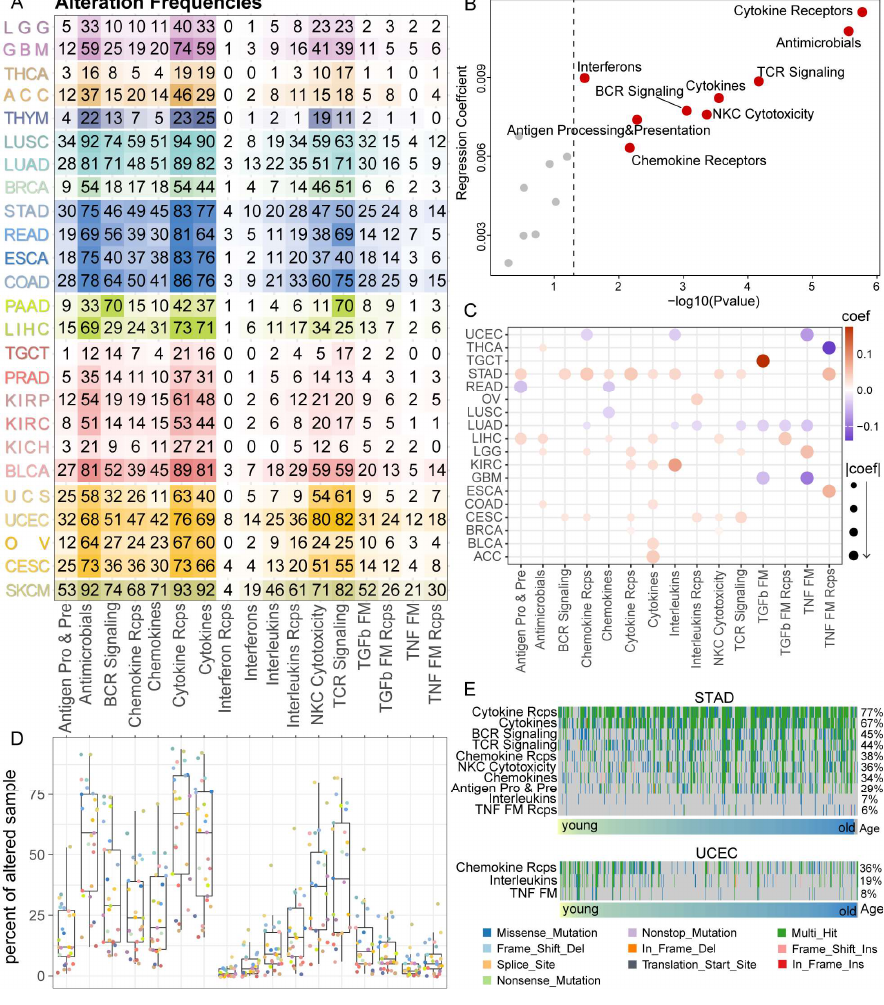
Figure 4. Alterations in immune-related pathways among 25 cancer types. ( A ) Heatmap showing the alteration frequencies of IRPs in various cancer samples, color intensities represent different percentages. ( B ) Volcano plots showing the associations between age and mutations in IRPs in pan- cancer. IRPs with significant positive correlations are highlighted in red. ( C ) Dotplot of associations between age and mutations in IRPs across various cancers. The color and size represent the logistic regression coefficients. ( D ) Boxplot showing the alteration frequencies of IRPs in various cancer samples. The color of dots denotes different cancer types (see Figure 1D). ( E ) Oncoplot of IRPs in STAD and UCEC.